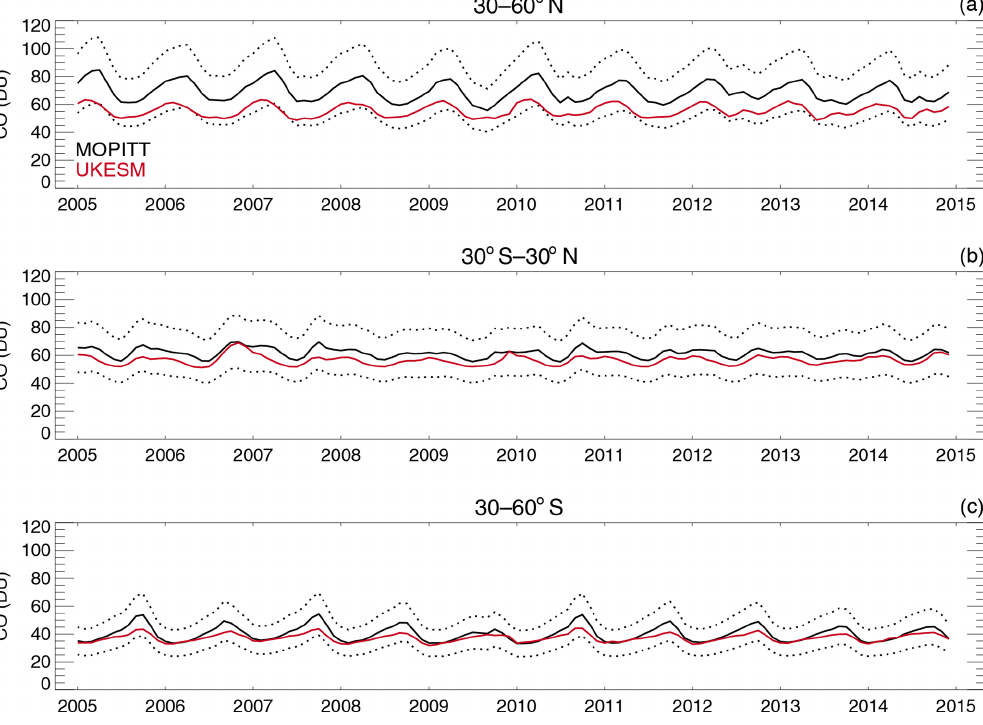
Figure 17. Tropospheric column CO (DU) zonal time series (30–60 ◦ N – a , 30 ◦ N–30 ◦ S – b , 30–60 ◦ S – c ) for the ND simulation (red) and MOPITT (black). Dashed lines represent the satellite uncertainty